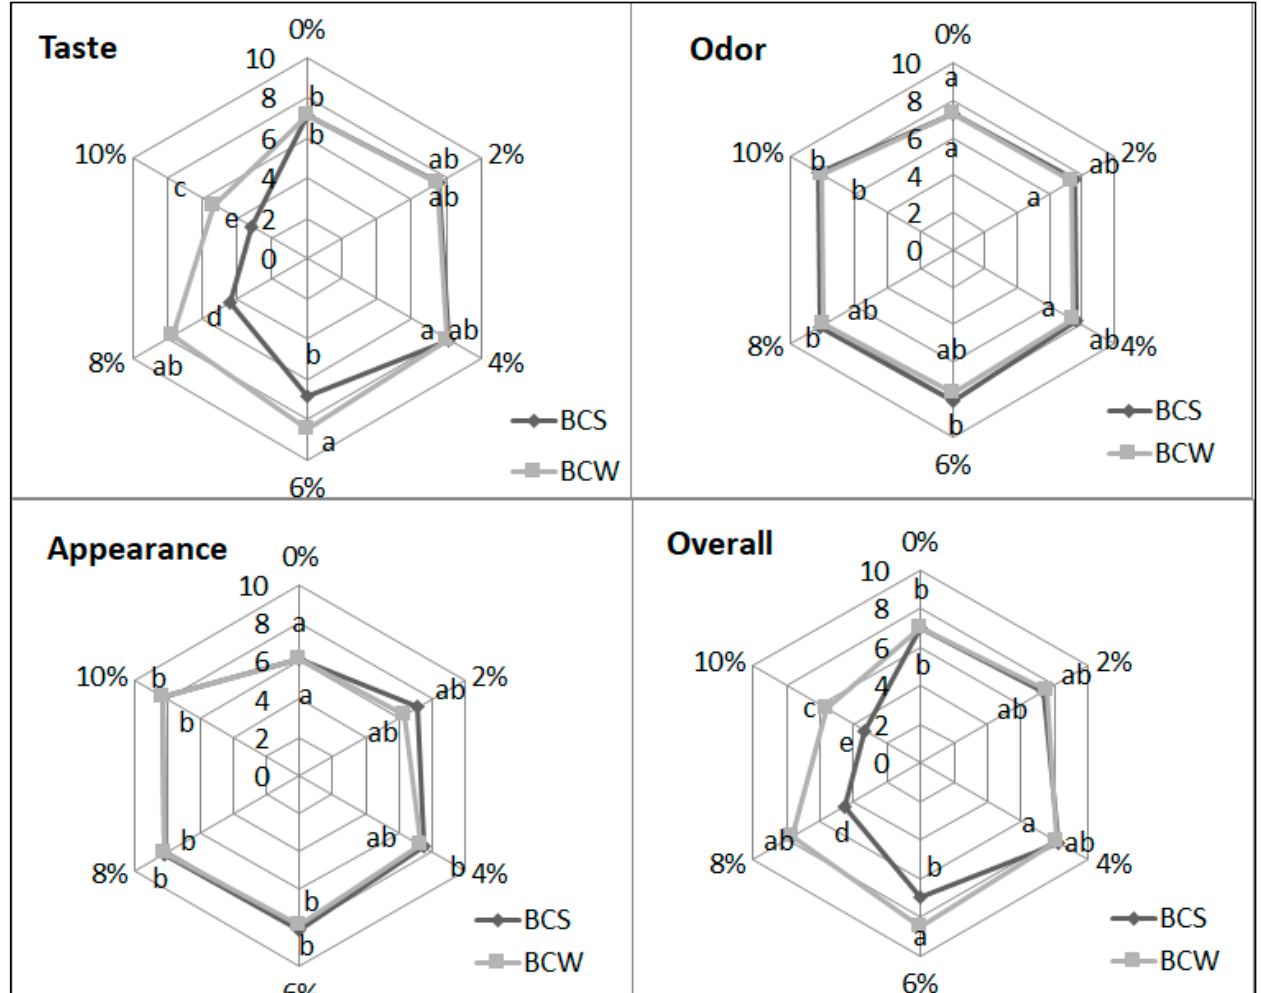
Figure 3. Sensory evaluation of starch bread with BCS and BCW: C—control starch bread, BCS—black cumin, BCW—black cumin pressing waste; mean values in the same figure marked with different letters are significantly ( α = 0.05) different. Table 3. Chemical composition and calorific value of starch bread prepared with BCS and BCW. Kind of Sample